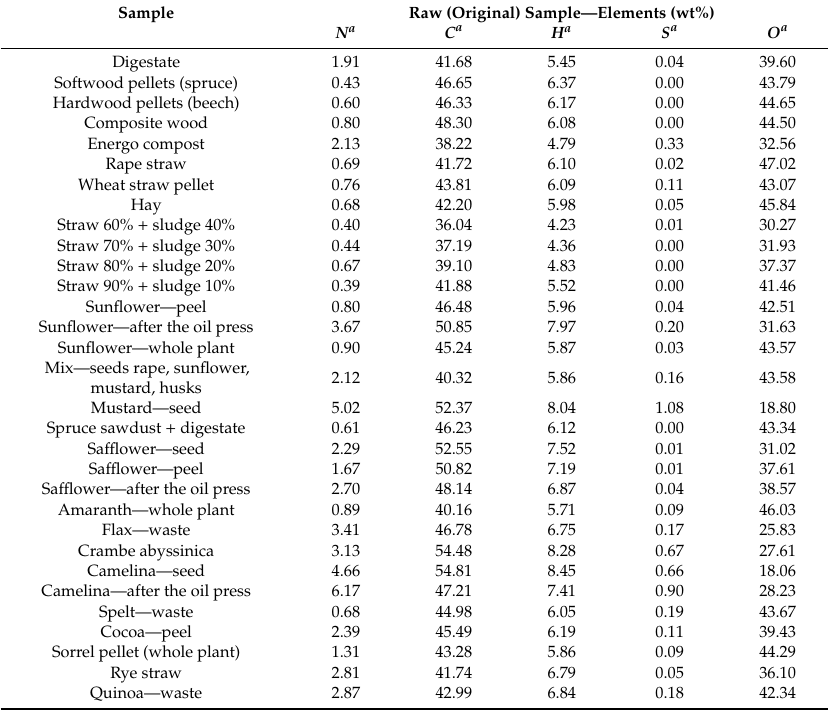
Table 6. Percentages of carbon, nitrogen, hydrogen, sulfur, and oxygen in the raw (original) samples of combusted material.